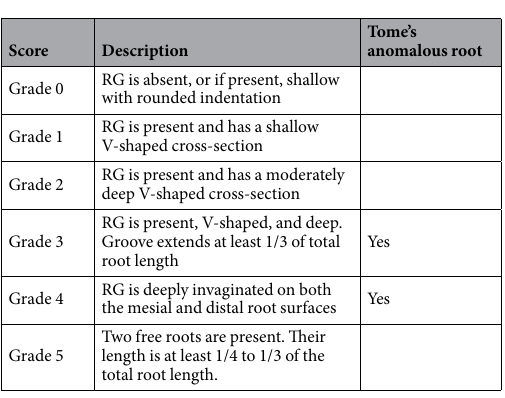
Table 5. Classification of Tome’s root according to Arizona State University dental anthropology scoring system 4 . RG: radicular